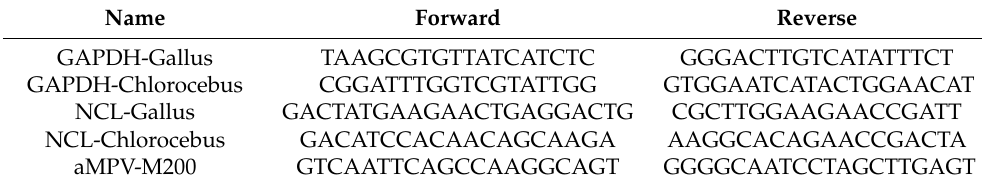
Table 2. Primers (5 (cid:48) -3 (cid:48) ) used in